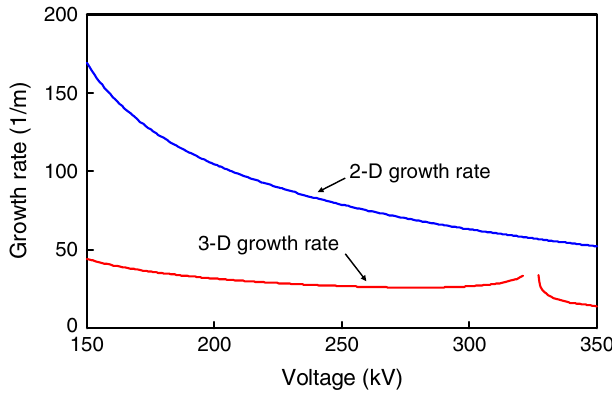
FIG. 6. Roots of the dispersion relation for region II. Forbidden regions are shaded. FIG. 7. (Color) Growth rate for the parameters of Table I.